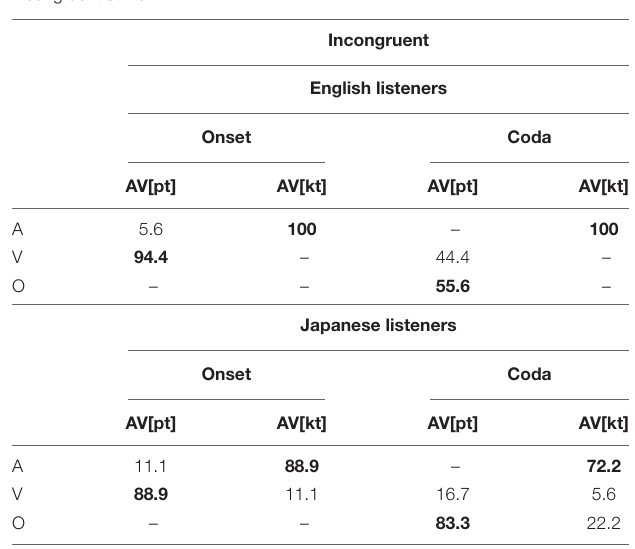
TABLE 8 | Proportion of responses in each category for non-fusible audio-visual incongruent